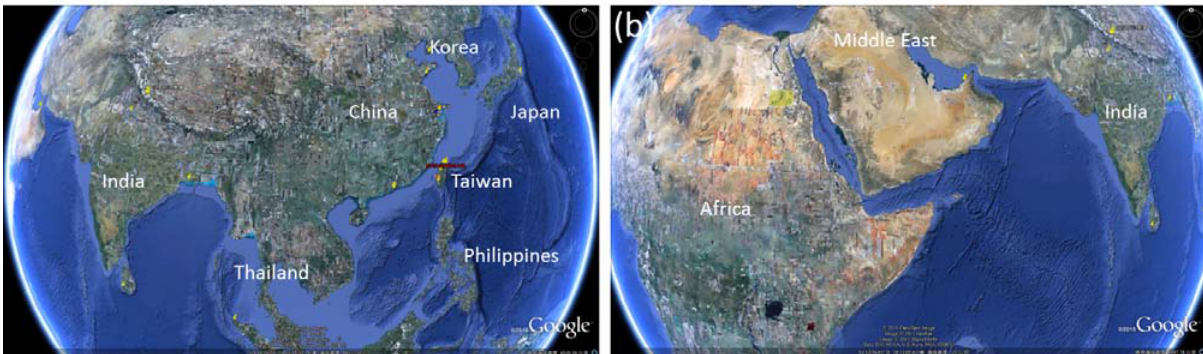
Figure 1. The screenshots showing the AOIs in (a) Asia and (b) Middle East and Africa from the 2009 Fall class. The AOIs are indicated by pins, polygons, or other marks provided in Google